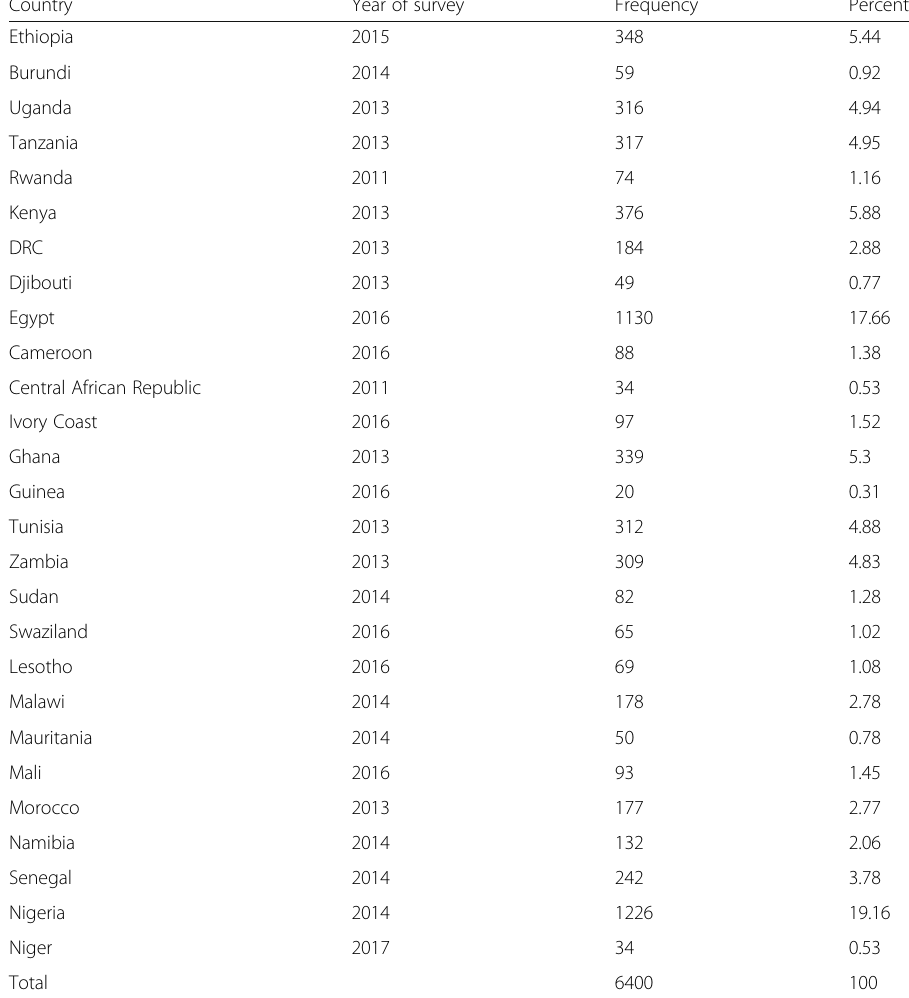
Table 1 Number of firms by country Country Year of